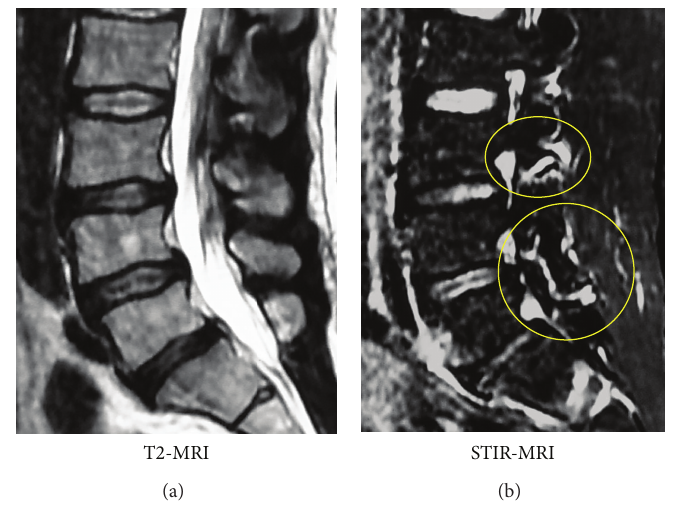
Figure 4: MRI at initial presentation shows in the left panel no obvious degenerative spinal disorder such as herniated nucleus pulposus or spinal canal stenosis. Slight disc degeneration at L3-L4, L4-L5, and L5-S1 is evident. In the right panel, effusion is also seen around the pars defects and surrounding facet joint.